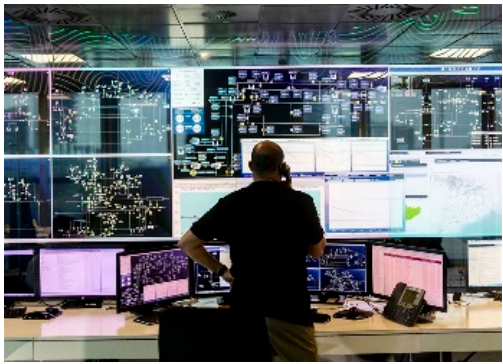
Figure 10. Computer-based decision support system for managing water. www.suez.com (accessed on 20 February 2021).